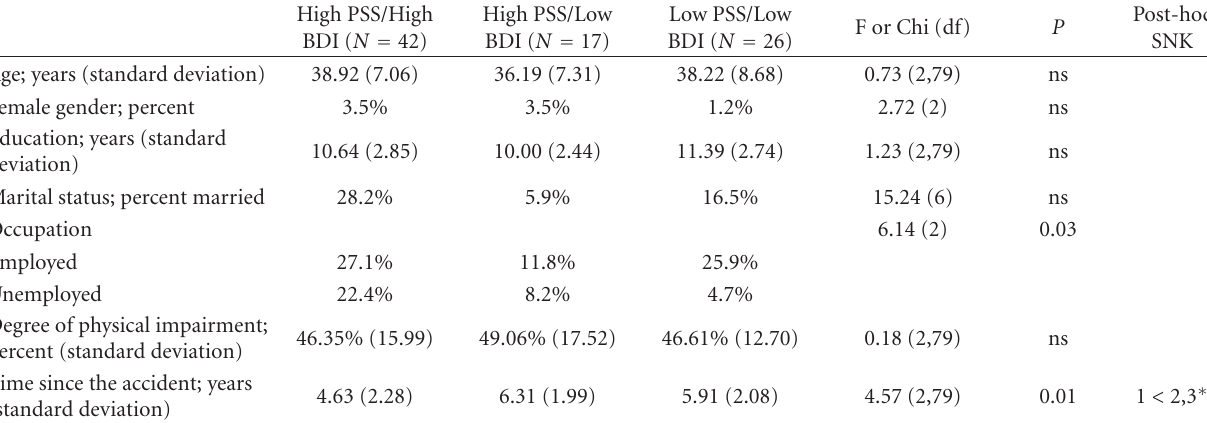
Table 2: Demographic characteristics of the three groups (High PSS/High BDI, High PSS/Low BDI, Low PSS/Low BDI).